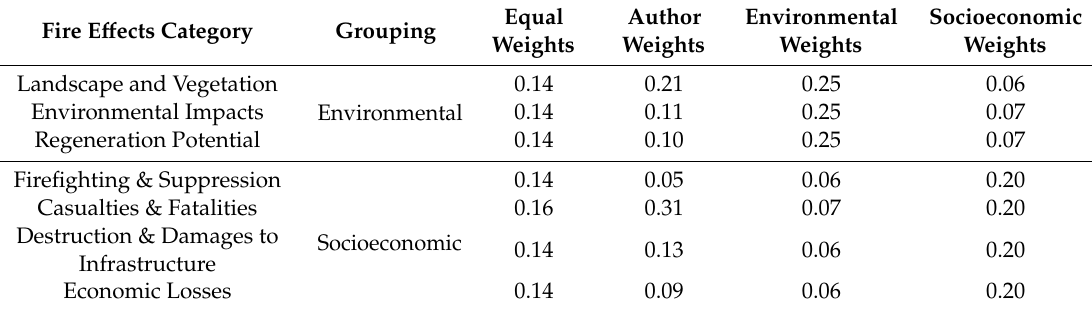
Table 10. The four alternative weight assignment scenarios tested during sensitivity analysis for the seven fire e ff ects